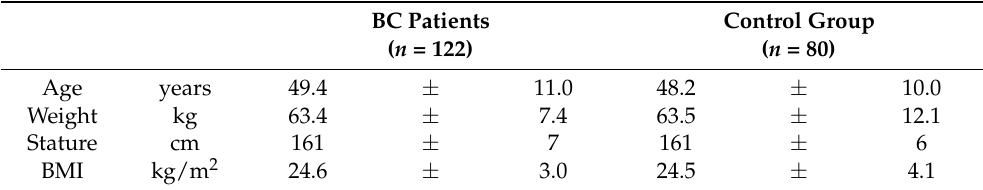
Table 1. Characteristics of breast cancer (BC) patients and the control group.